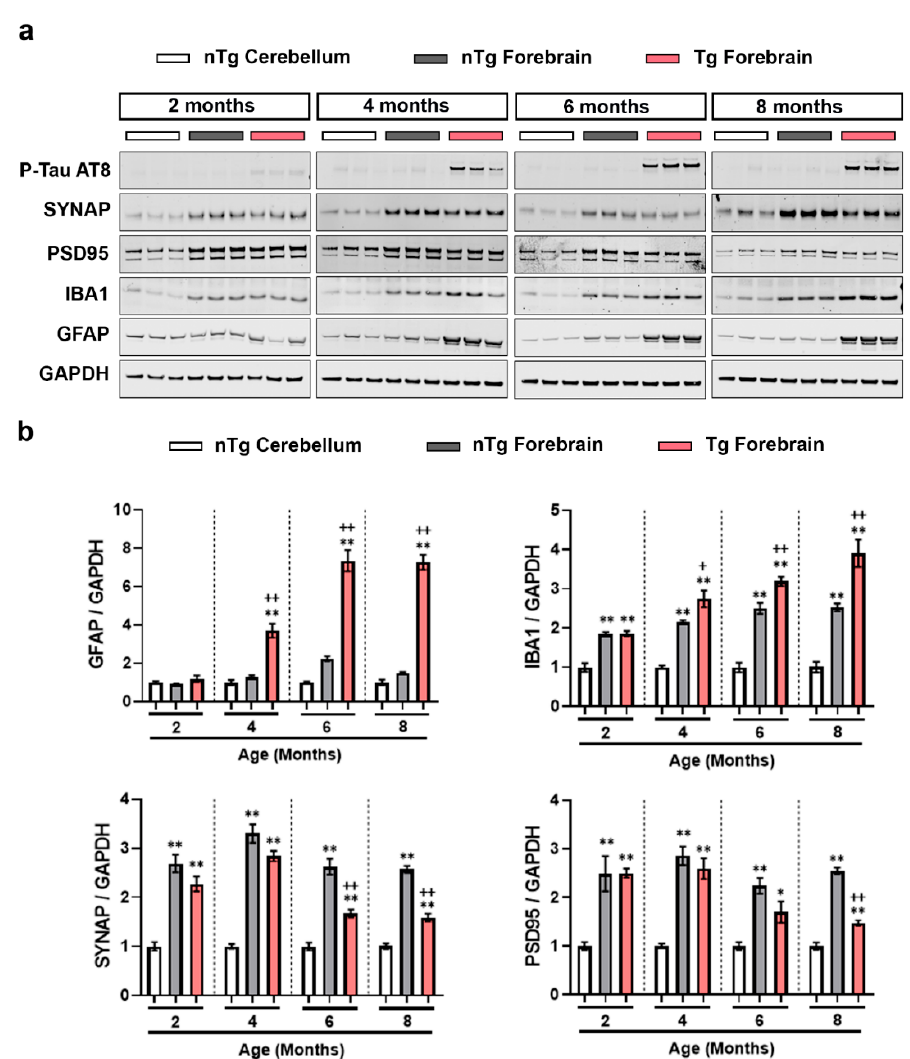
Figure 5. Expression of neuronal injury markers and synaptic markers in rTg4510 mouse brain. ( a ) Representative immunoblots of p-TAU AT8, SYNAP, PSD95, GFAP, and IBA1 from the homogenates obtained from nTg cerebellum as well as nTg and Tg forebrain of 2, 4, 6, and 8 months old female mice. ( b ) Quantification of the immunoblots of GFAP / GAPDH, IBA1 / GAPDH, SYNAP / GAPDH and PSD95 / GAPDH, from the homogenates obtained nTg cerebellum, nTg forebrain and Tg forebrain of 2, 4, 6, and 8 months old female mice, plotted as mean fold change relative to nTg cerebellum group of respective age cohort. One-way repeated measure ANOVA followed by Tukey’s multiple comparisons test. * p < 0.05, ** p < 0.01 relative to nTg cerebellum; + p < 0.05, ++ p < 0.01 relative to nTg forebrain, n =